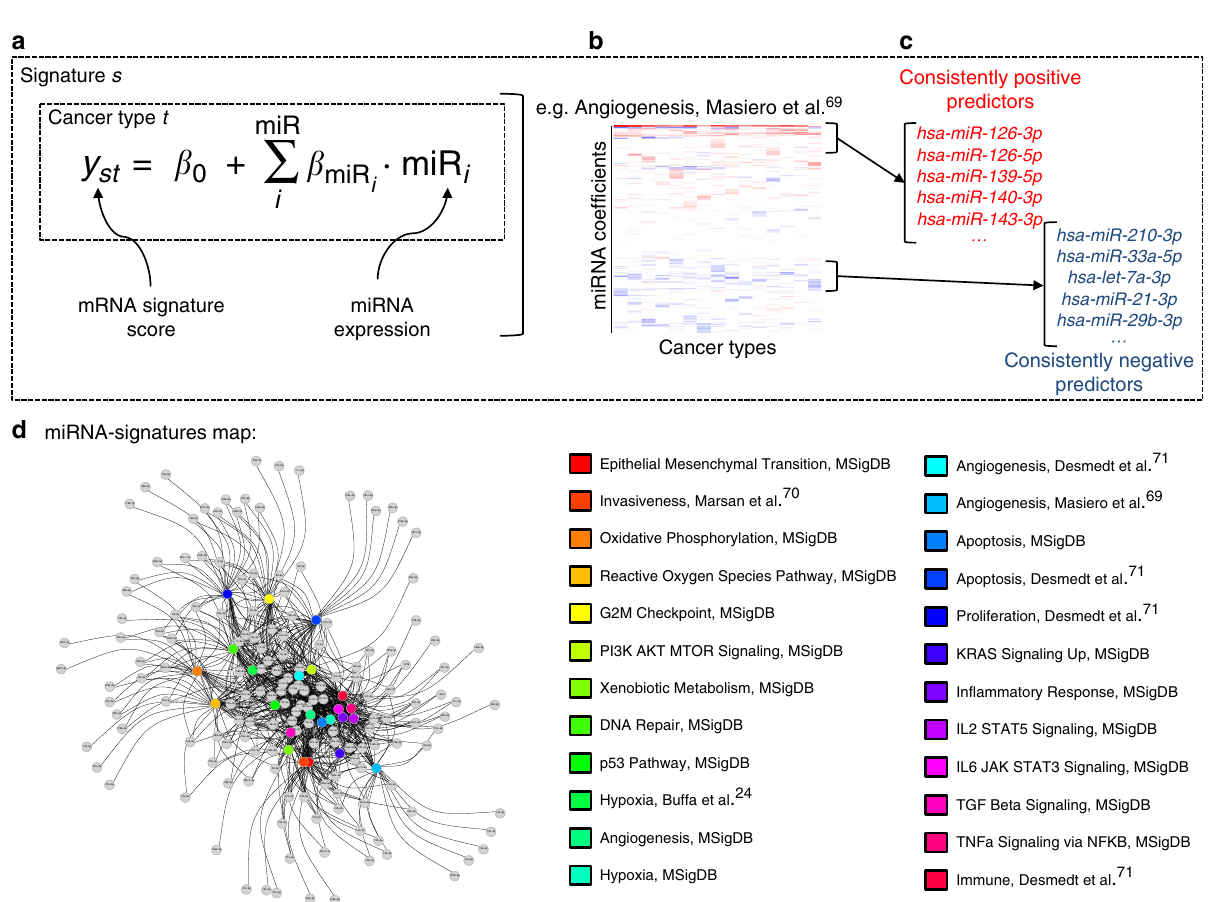
Fig. 1 Overview of approach used to identify hallmarks-associated miRNA. a Overview of the linear model used in the fi tting, for each gene signature and cancer type under consideration. b Example of a heatmap depicting the values of the coef fi cients identi fi ed for the miRNA predictors (rows), across cancer types (columns) for our previously developed angiogenesis signature 69 . c Consistently positive and negatively ranking miRNA coef fi cients, identi fi ed as statistically signi fi cant by the rank product statistic, are taken as the positive and negative hallmark-associated miRNA for each hallmark signature. d Network map of signatures (coloured circles) and their positively associated miRNA (grey circles), connected by edges when an association was